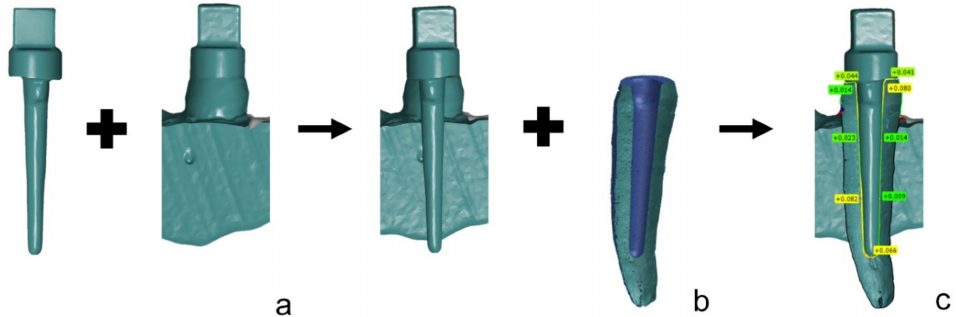
Figure 6. Example of triple-scan-method with superimposition of digitized CAD/CAM-P+C and CAD/CAM-P+C seated in the model ( a ), and subsequent superimposition with µ -CT reference dataset ( b ) to analyze the accuracy of fit at determined measurement points ( c ).